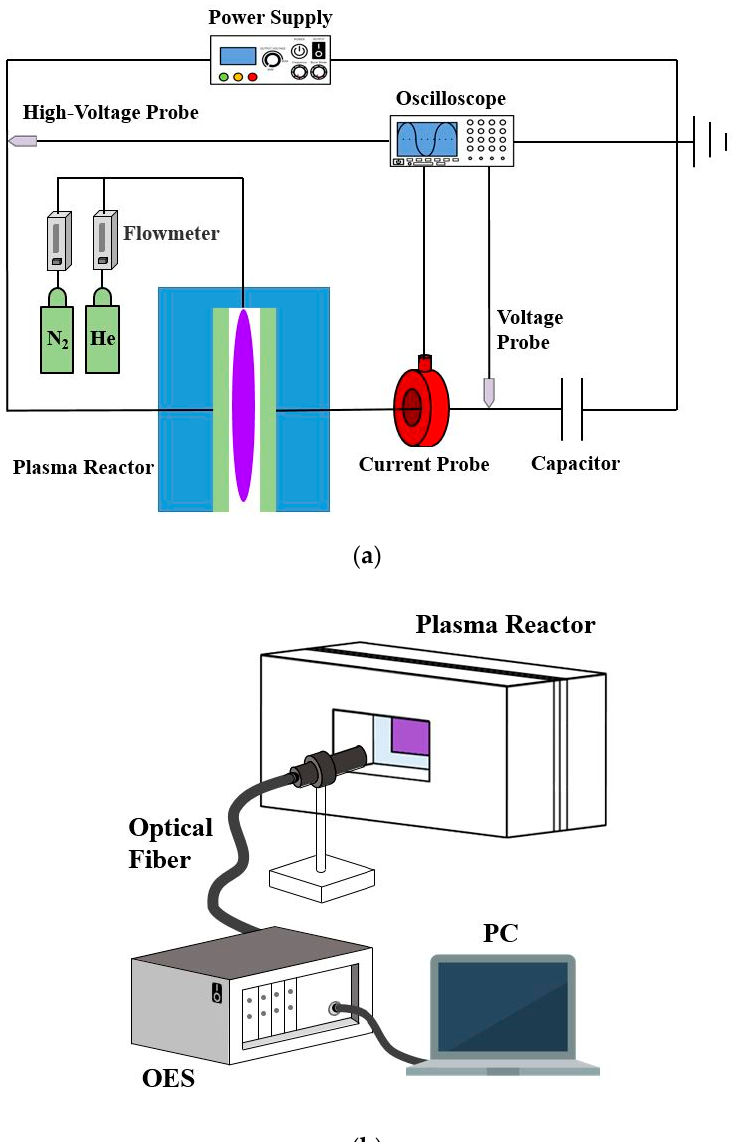
Figure 1. The schematic diagrams of ( a ) the experimental configuration; ( b ) the measurement of the emission spectrum with an optical emission spectrometer (OES).